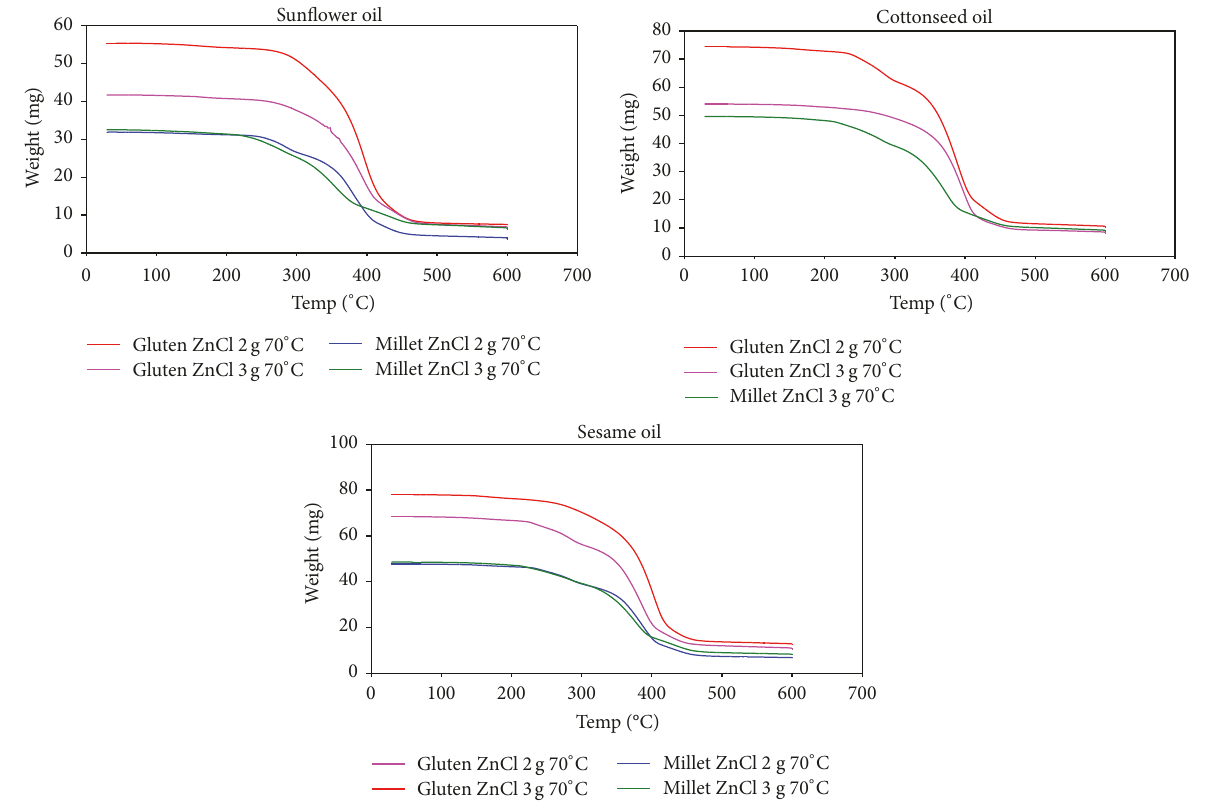
Figure 2: TGA degradation kinetics of epoxy